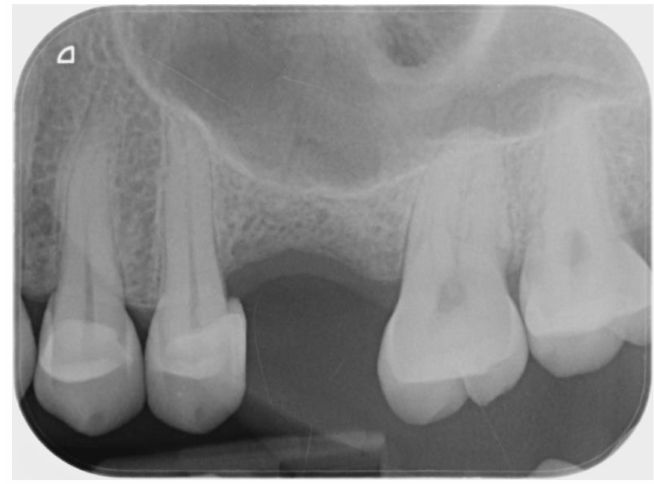
Figure 1. Intra-oral pre-operative x-ray of the edentulous